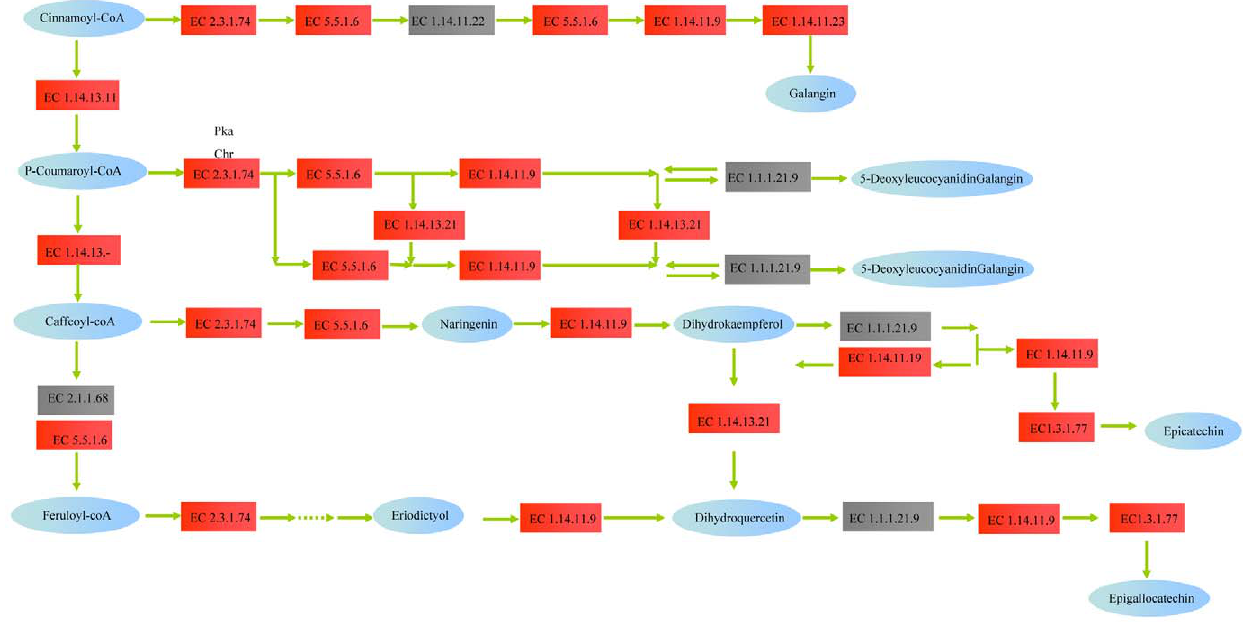
Figure 4. Unigenes predicted to be involved in the flavonoid biosynthesis pathway. Red indicates significantly increased expression; gray indicates genes that were not identified in the expression profile analysis; blue indicates unigenes predicted to be involved in the pathway.